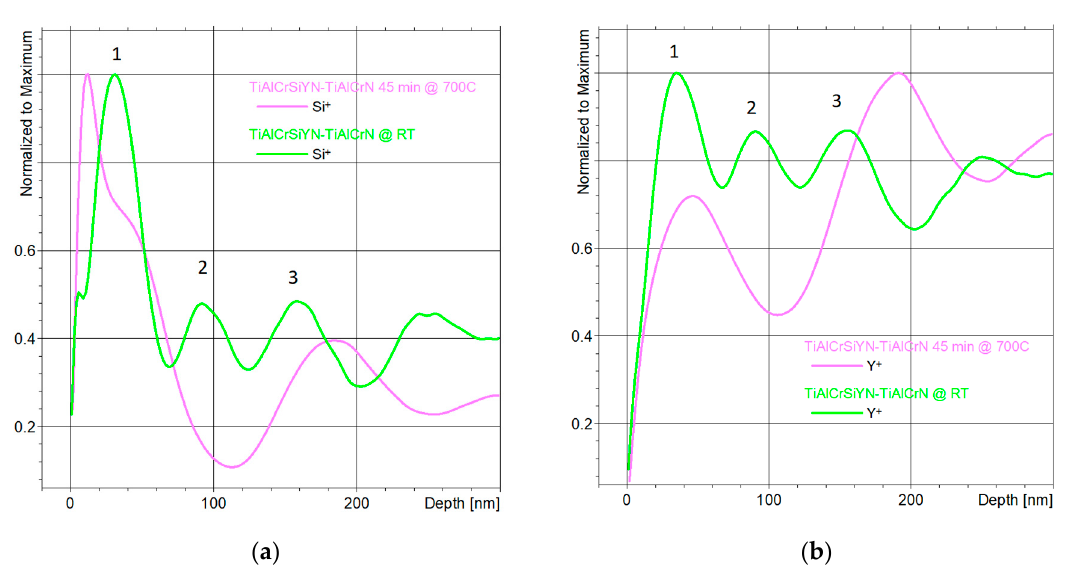
Table 1. The change in the depth penetration, Δ X, of silicon and yttrium in the layers at the initial stage and after annealing at a temperature of 700 °C for Ti 0.2 Al 0.55 Cr 0.2 Si 0.03 Y 0.02 N/Ti 0.25 Al 0.65 Cr 0.1.